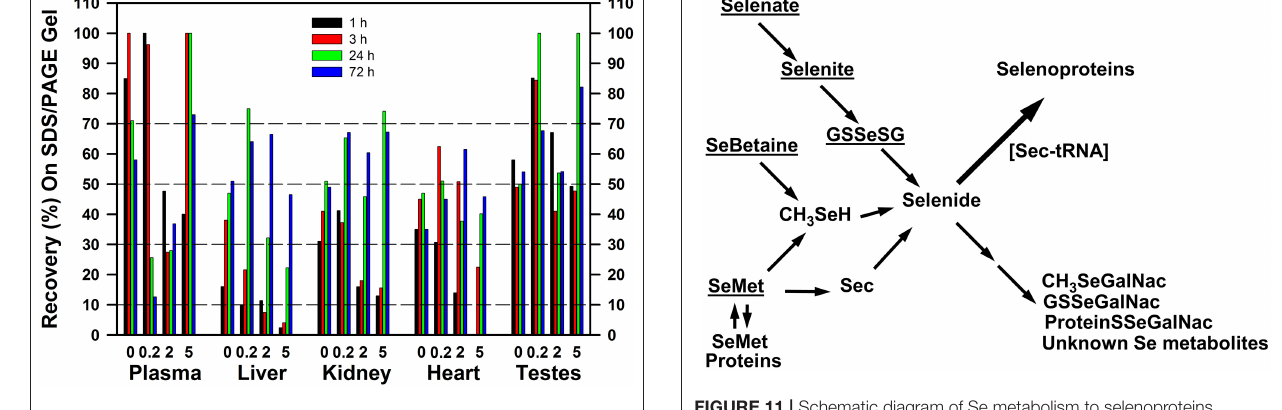
FIGURE 9 | Recovery of 75 Se from [ 75 Se]selenite as 75 Se-labeled selenoproteins on SDS/PAGE gels. Rats were supplemented with 0, 0.2, 2, or 5 µ g Se/g diet as selenite for 50–80 d, injected iv with 50 µ Ci of [ 75 Se]selenite, and were tissues subjected to SDS/PAGE as described for Figures 2 – 6 ( n = 16 total rats). Values are the percent of the applied 75 Se recovered in the gel after SDS/PAGE in the indicated tissues at the indicated times.